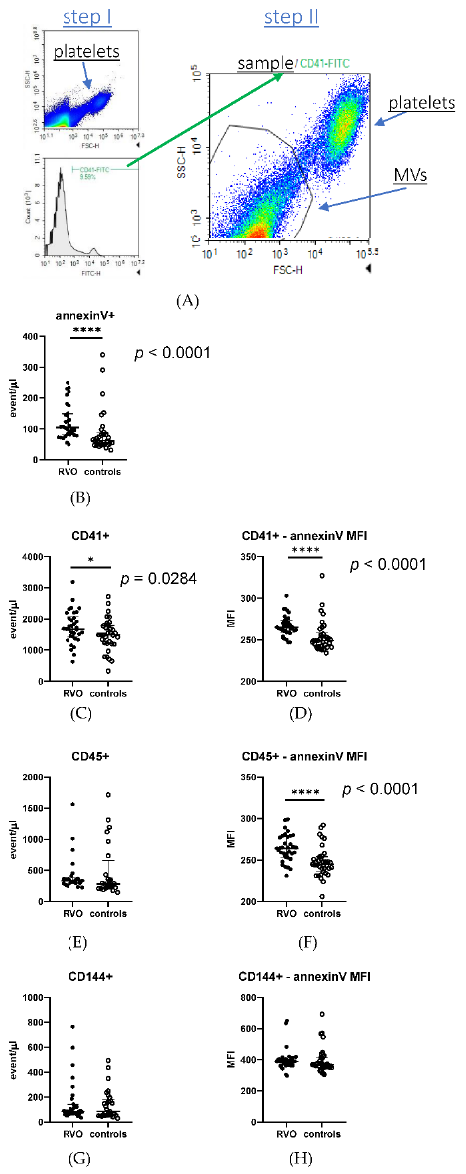
Figure 1. RVO is associated with increased number of procoagulant and platelet-derived microvesicles (MVs). The MV gating schema: the population of antigen-positive events is selected based on a histogram, and within that population the MVs are selected as the events smaller than platelets based on SSC/FSC plot ( A ). The graphs present the dot-plots with median and interquartile ranges (whiskers) of the antigen-positive MV populations, presented as densities, of procoagulant (annexinV-positive) ( B ), platelet-derived (CD41-positve) ( C ), leukocyte-derived (CD45-positive) ( E ), and endothelium-derived (CD144-positive) ( G ) MVs. Graphs ( D , F , H ) present the annexin V median florescence intensity (MFI) within the indicated antigen-specific MV population. Significance of differences between RVO and controls was estimated using the Mann–Whitney U test. * p < 0.05; **** p < 0.0001. RVO—Retinal Vein